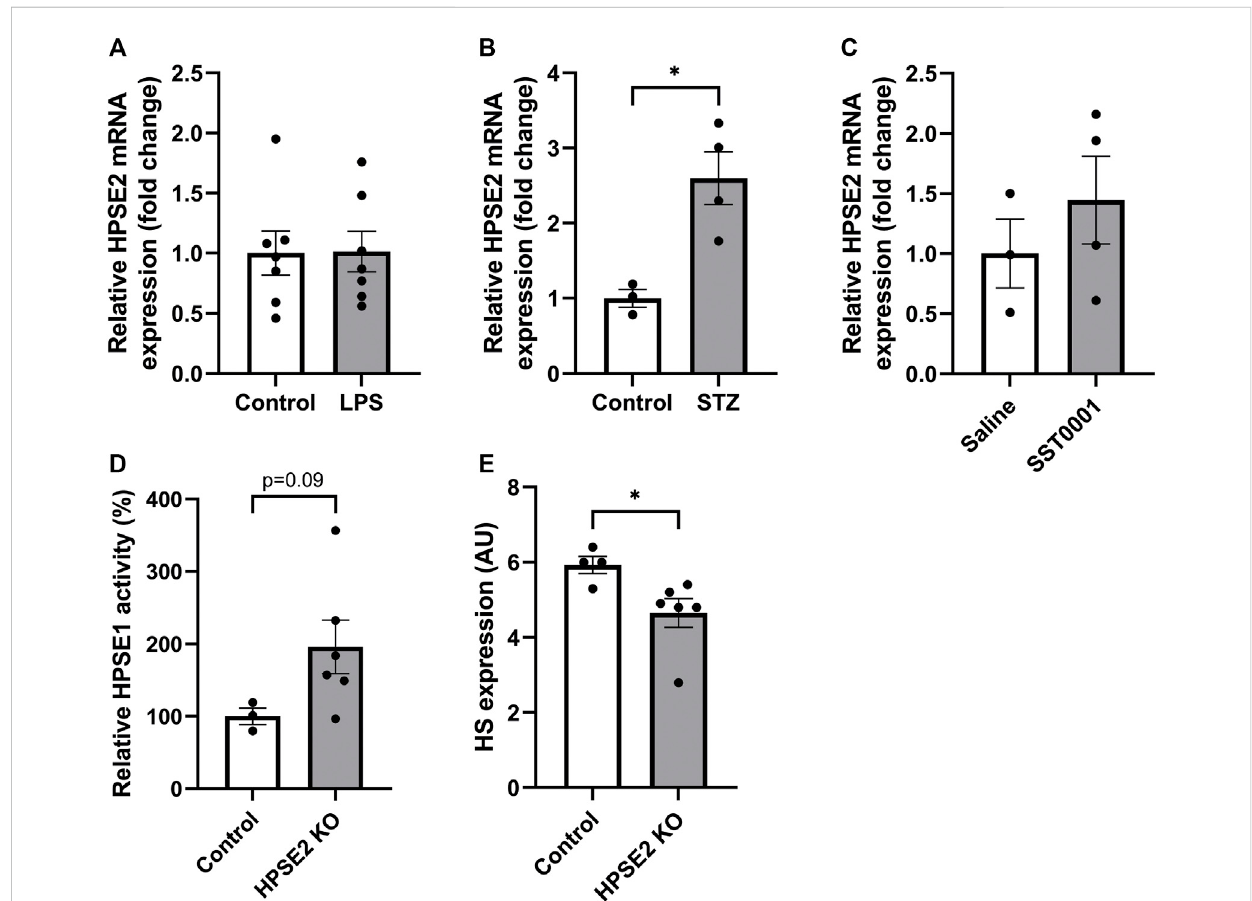
FIGURE 3 Relation between HPSE1 and HPSE2 regulation in glomerular disease reveals a possible connection (A) . Renal cortical HPSE2 mRNA expression of HPSE1 KO mice treated with or without LPS for 2 days (B) . Renal cortical HPSE2 protein expression of HPSE1 KO mice treated with or without STZ for 16 weeks (C) . Renal cortical HPSE2 mRNA expression of type 2 diabetic mice treated with HPSE1 inhibitor SST0001 or left untreated (D) . Relative HPSE1 activity of untreated wild-type mice or HPSE2 KO mice (E) . Glomerular HS expression of untreated wild-type mice or HPSE2 KO mice. Data are expressed as mean ± SEM. n ≥ 3 * p < 0.05. HPSE2, heparanase-2; AU, arbitrary units; HPSE1, heparanase-1; KO, knock-out; STZ,